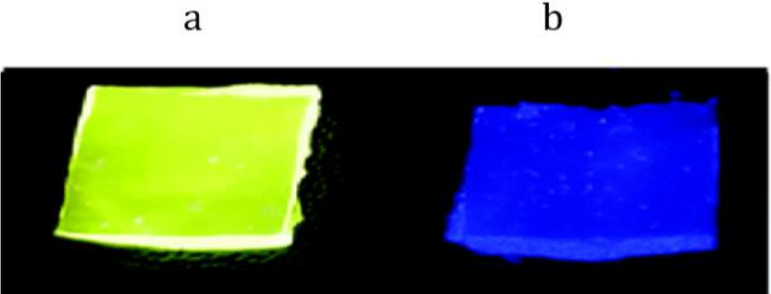
Figure 8. Optical photographs of thermo-photoluminescent silicone rubbers at 80 °C ( a ) and 120 °C ( b ). Reproduced with permission [98]. Copyright 2021, Royal Society of Chemistry.